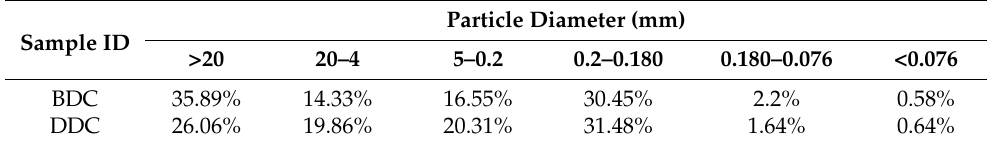
Table 2. Mass ratio of particle diameter in TDC samples.